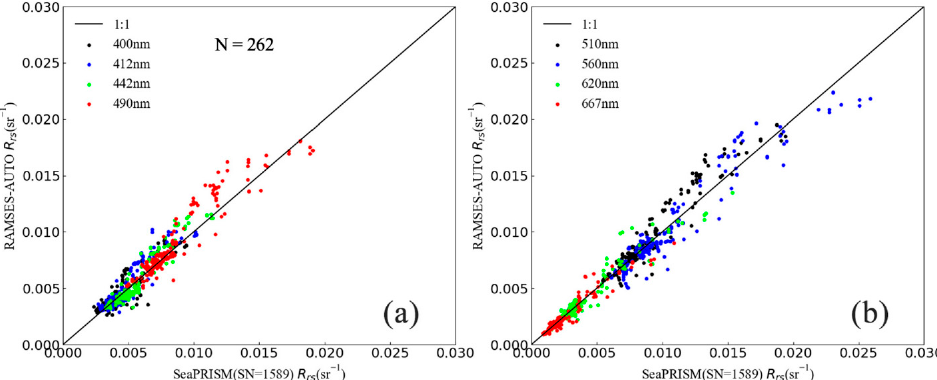
Figure 7. Scatter plots of remote sensing reflectance ( R rs ) comparison between the SeaPRISM and RAMSES-AUTO at wavelengths of ( a ) 400, 412, 442, and 490 nm, and ( b ) 510, 560, 620 and 667 nm. Table 4. Statistical parameters for the comparison of R rs determined by SeaPRISM and RAM- SES_AUTO at the Muping site including median relative percentage difference (MRPD), root mean square error (RMSE, in sr − 1 ), mean ratio (mR), mean bias (mB, in sr − 1 ), and Pearson correlation effi- cient (r).